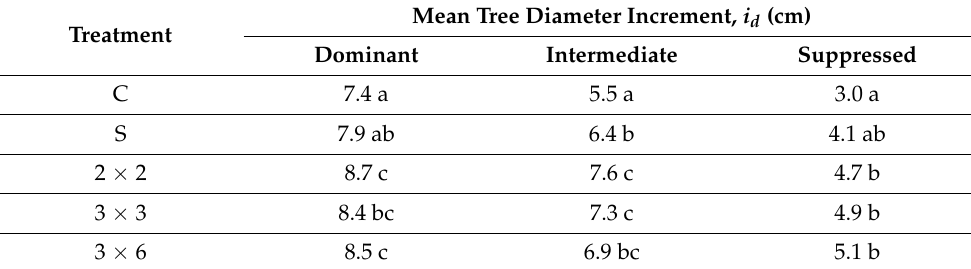
Table 3. Mean tree diameter increment ( i d ) for different crown classes (dominant, intermediate, sup- pressed) in Pyrenean oak coppice. The same letter in the column indicates the group subset and nonsignificant differences from the mean comparison test, at the 5% significance level.